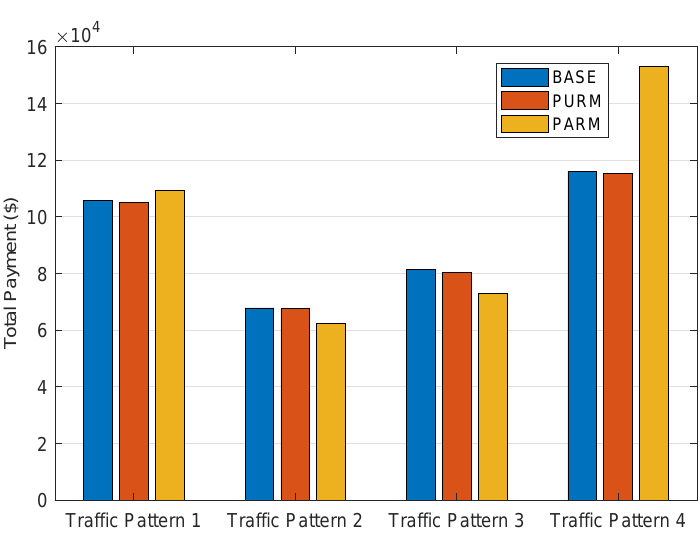
Figure 9. Comparison of total Bandwidth Cost.